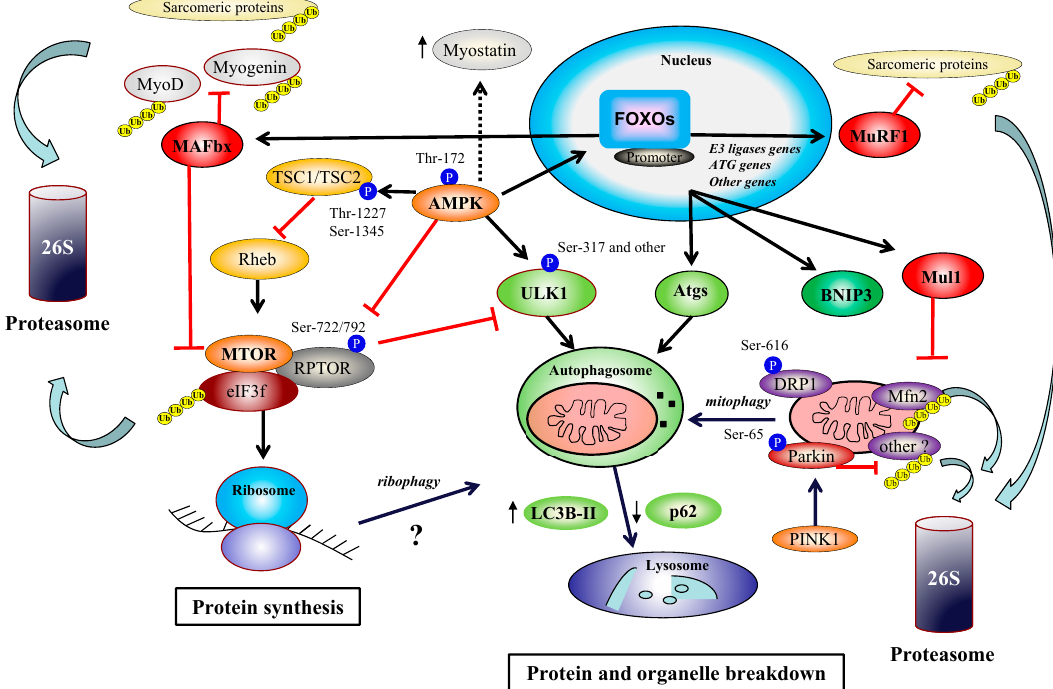
Figure 1. (AMP)-activated protein kinase (AMPK), forkhead box class O subfamily protein (FOXO), and mechanistic (or mammalian) target of rapamycin complex 1 (MTORC1) in the regulation of protein and organelle turnover. FOXO proteins increase the transcription of the E3 ubiquitin protein ligases muscle atrophy F-box (MAFbx) / atrogin-1, muscle RING finger 1 (MuRF1), mitochondrial E3 ubiquitin protein ligase (Mul1), several autophagic genes (Atgs), and BCL2 / adenovirus E1B 19 kDa protein-interacting protein 3 (BNIP3) in muscle cells. MTOR and AMPK di ff erentially modulate autophagy initiation by phosphorylation of the Unc-51-like kinase (ULK1). AMPK also activates FOXO1 and FOXO3 and tuberous sclerosis complex 2 (TSC)1 / TSC2 complex, and inhibits MTORC1 complex through phosphorylation of the associated regulatory protein of MTOR complex-1 (RPTOR). MAFbx / atrogin-1 and MuRF1 target sarcomeric proteins. MAFbx / atrogin-1 also targets factors involved in cell growth including the transcription factors Myogenin and MyoD, and the eukaryotic initiation factor 3f (eIF3f). PTEN-induced putative kinase protein 1 (PINK1) / Parkin and Mul1 axes enhance mitophagy through ubiquitination of mitochondrial